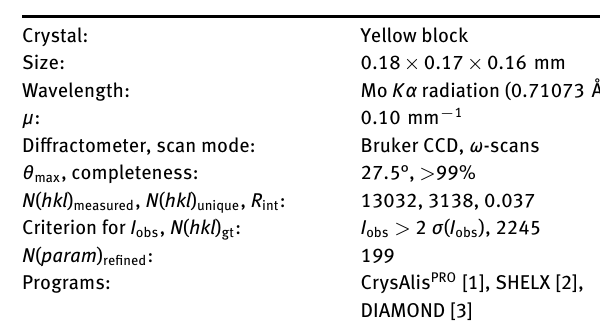
Table 1: Data collection and